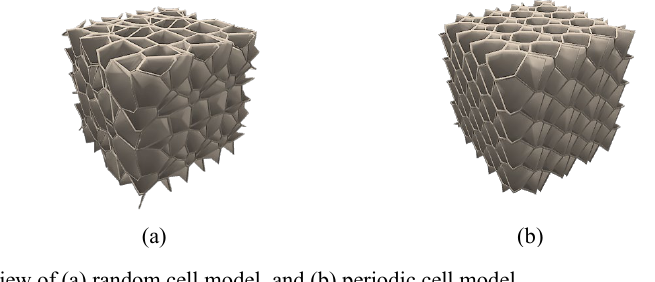
Fig.1. External view of (a) random cell model, and (b) periodic cell model.